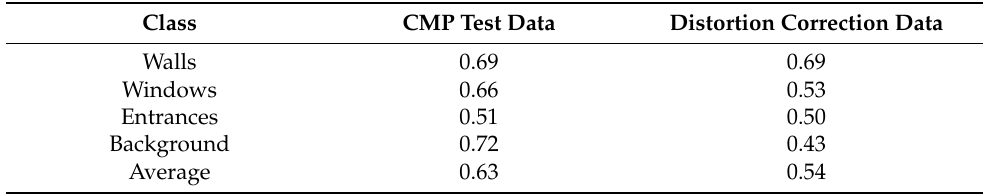
Table 14. mIoU of CMP test and distortion correction